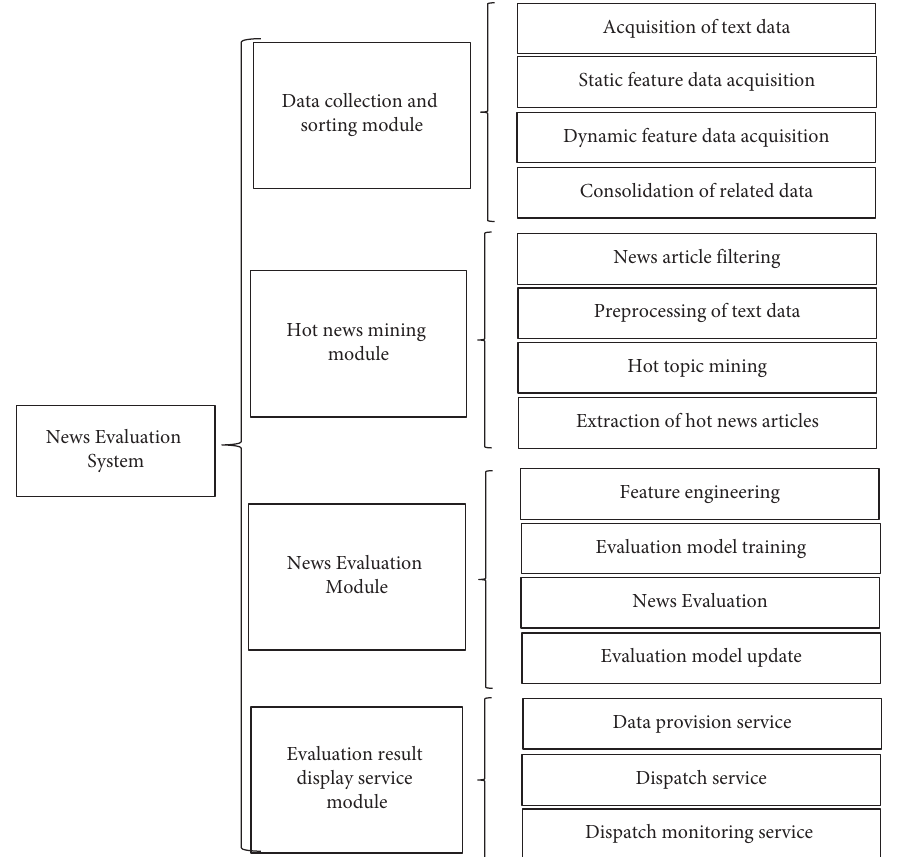
Figure 8: The functional design of the news evaluation